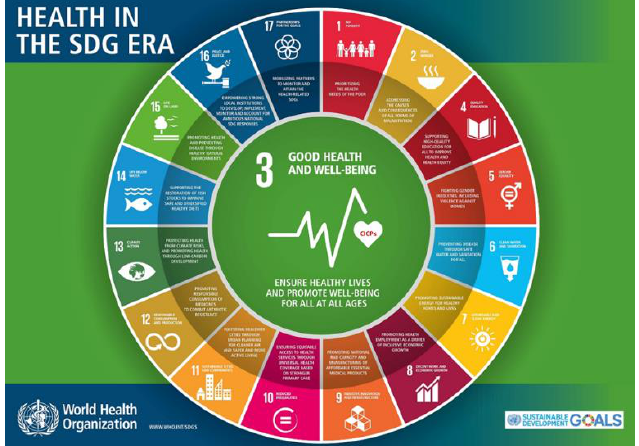
Figure 2: Community and Informal Care Providers (CICPs) at the Heart of Good Health and Well-being (Adapted from the WHO Health in the SDG Era